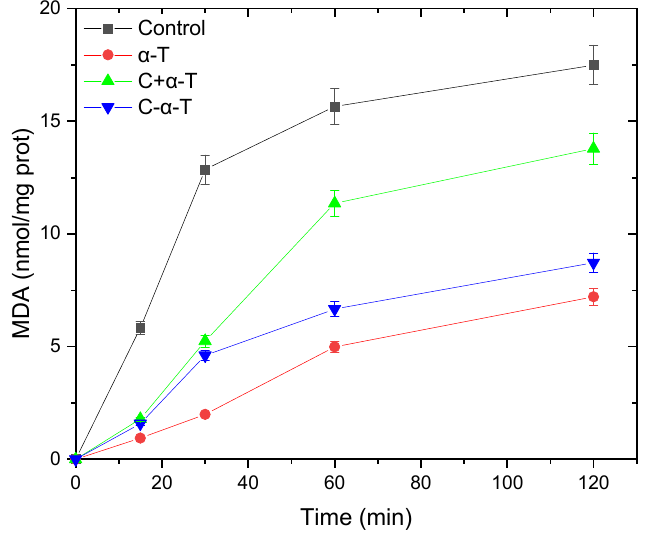
Figure 7. Antioxidant activity of α -T, and of CH+ α -T and CC- α -T nanoparticles. Results indicate means of three independent experiments performed in triplicate (bars, standard deviation).